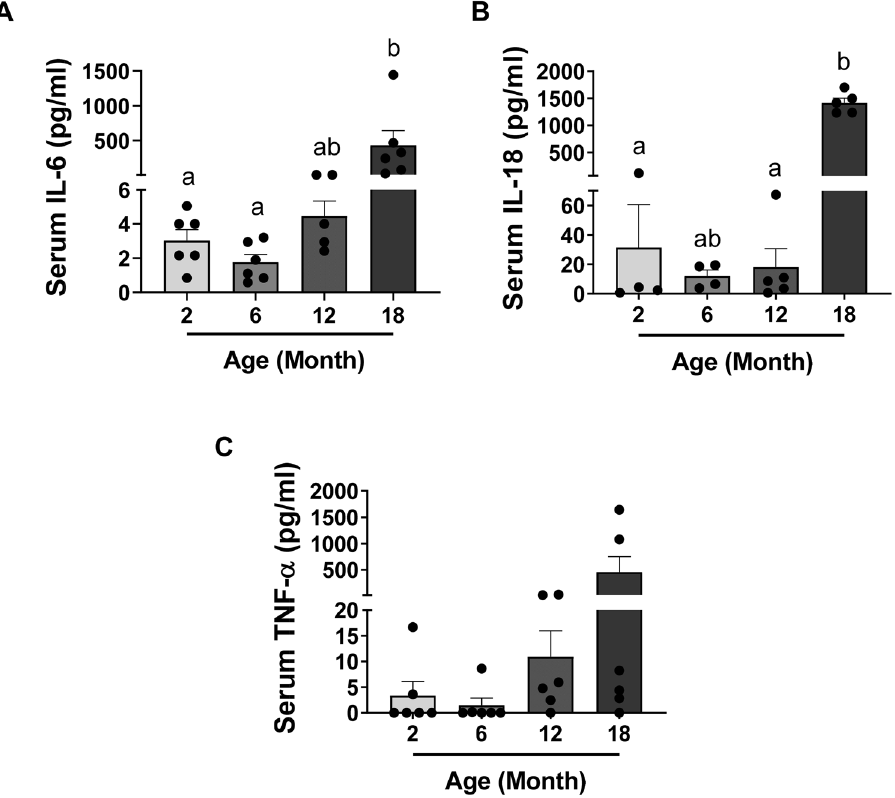
Figure 5. Reproductive ageing is accompanied by an increase in the serum levels of inflammatory cytokines IL-6 and IL-18. Serum IL-6 ( A ), IL-18 ( B ) and TNF-α ( C ) concentration measured in 2, 6, 12 and 18-month-old mice. n = 4–6 per cohort. Data are presented as mean ± SEM; Kruskal–Wallis test, Dunn’s multiple comparisons test: a and b are significantly different among groups ( p < 0.05). Each dot represents one